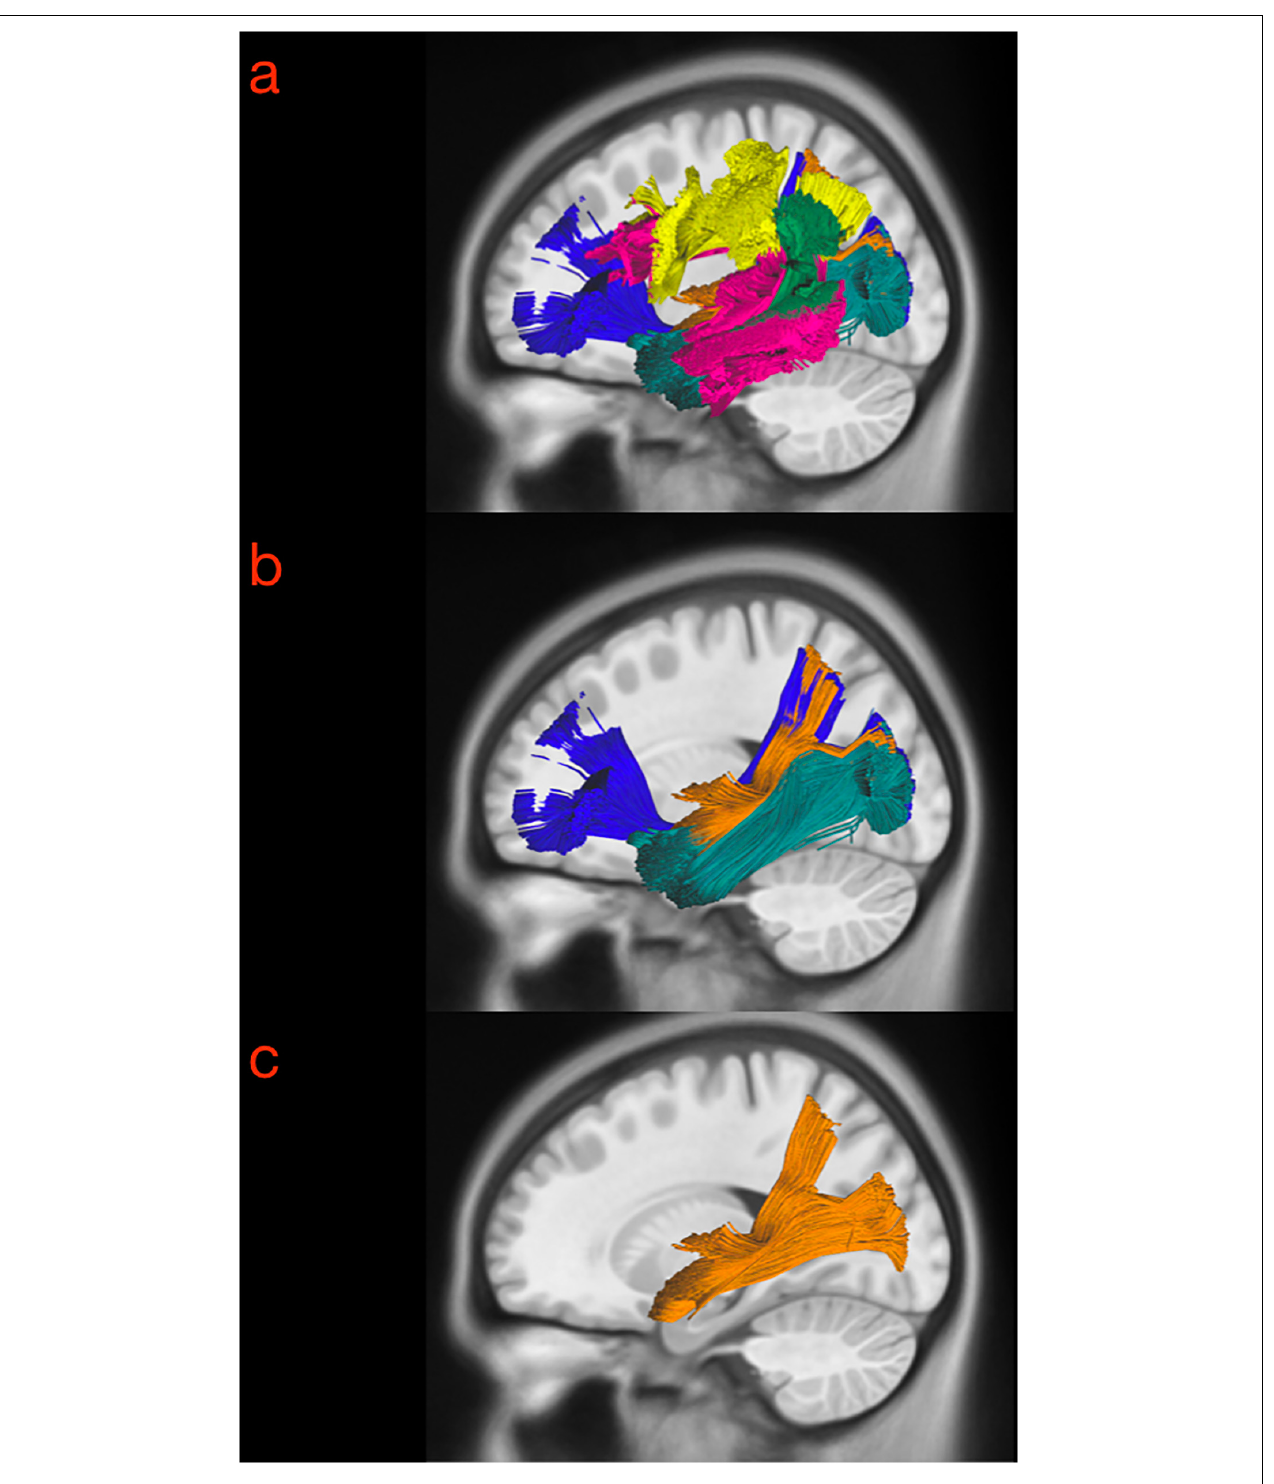
FIGURE 5 | Three exemplary steps of the virtual in-vivo dissection technique. (a) The first and more lateral white matter bundle such as the vSLF (green), hSLF (yellow) were identified as well as the course of the AF (pink), which is lateral and posterior compared to the MdLF in its temporal component, and represented the landmark for the identification of the MdLF stem. (b) ROAs were then subtracted from the ROIs describing the AF and vSLF to show the superficial layer of the sagittal stratum including MdLF fibers (orange) and ILF fibers (dark green). (c) The ILF, IFOF (dark blue), optic radiation (light blue) medial to this level were subtracted from the virtual dissection according to the clear anatomical differences in the course of their fibers. As a result, the MdLF stem was identified and isolated in three-dimensional space.